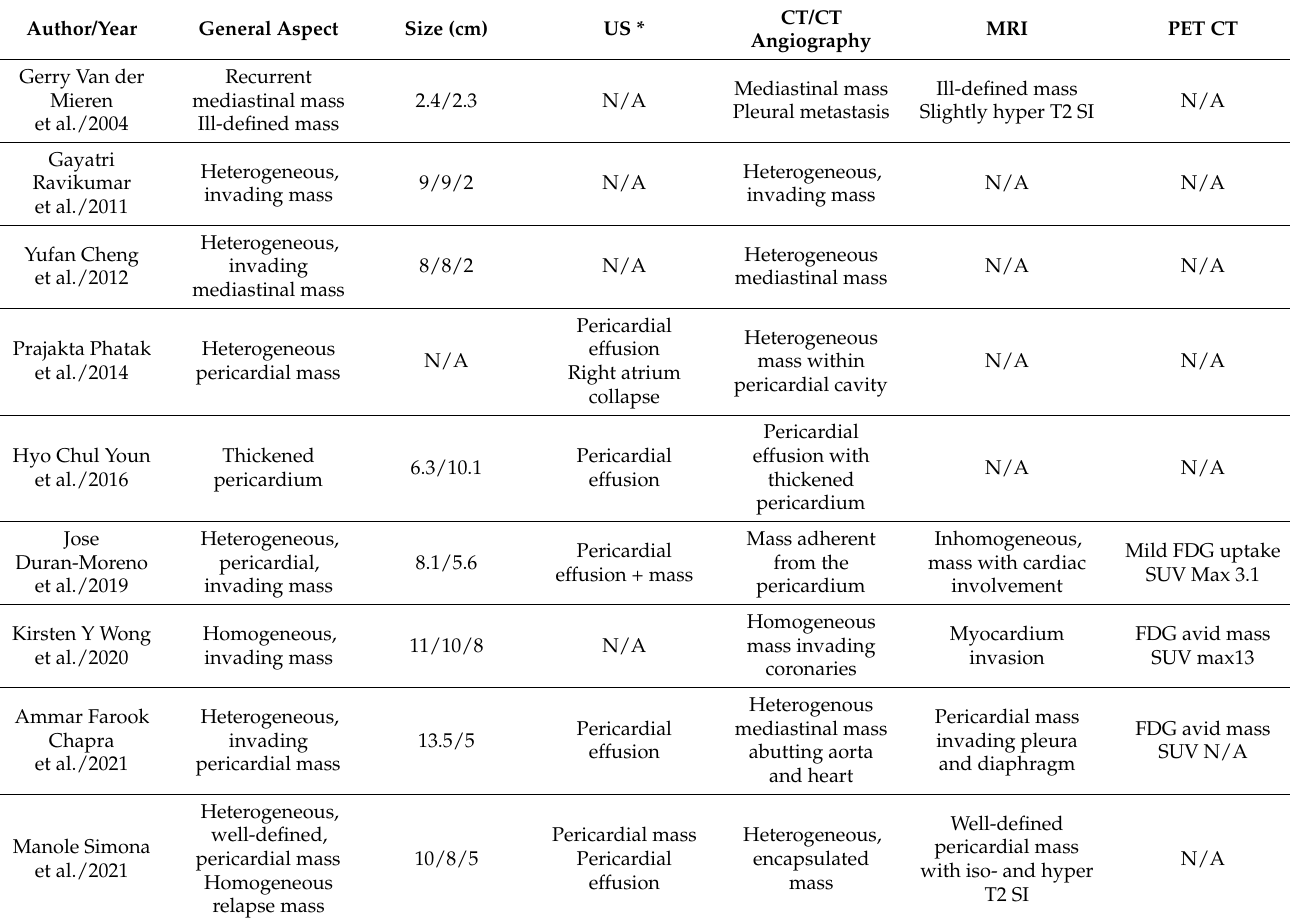
Table 1. Pericardial synovial sarcoma—reported imaging